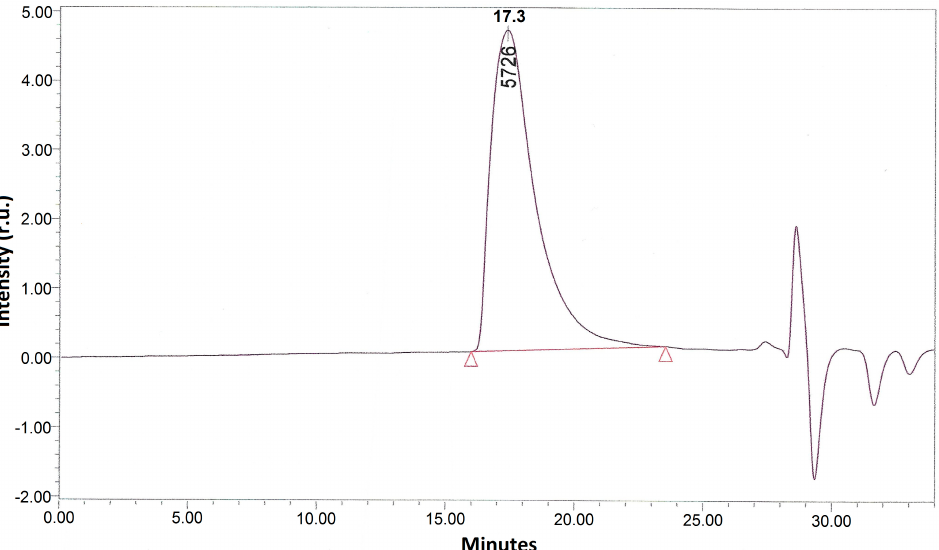
Figure 5. SEC (size-exclusion chromatography) elution profile of the reaction mixture obtained at the first stage, after its purification by reprecipitation. The red line and triangles indicate the signal boundaries of the main reaction product.